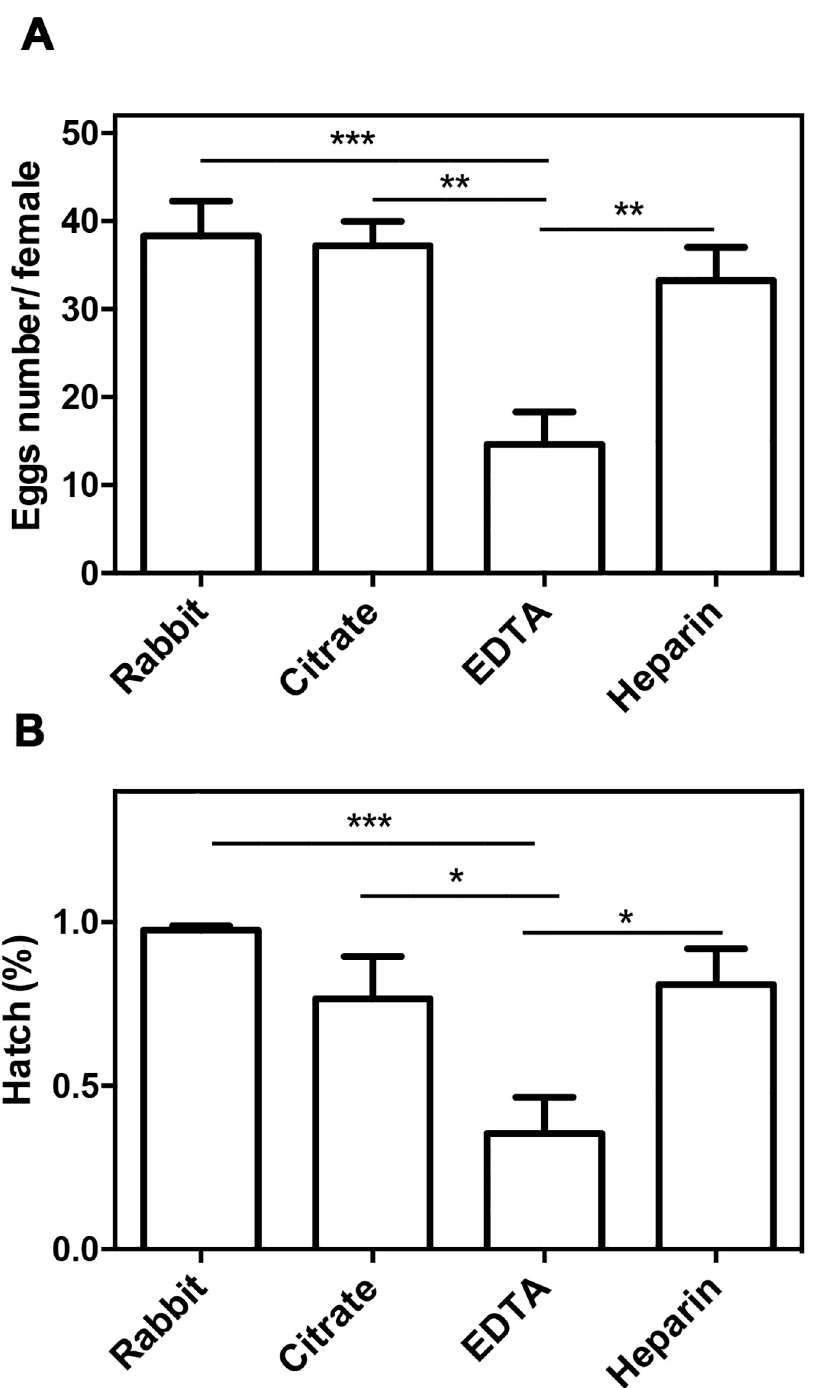
Fig 2. Effects of anticoagulants on fertility. Females were fed on live rabbit or artificially on blood collected with citrate, EDTA, or heparin as anticoagulants. After 40 days, the number of eggs (A) and nymphs was quantified, and the hatch percentage was calculated (B). Statistical analysis: one-way ANOVA, followed by Tukey test, total females number observed N Rabbit 12, N citrate 10, N EDTA 8, N Heparin 12 (A), and total number of eggs observed N Rabbit 470, N citrate 372, N EDTA 117, N Heparin 399. � P < 0.05; �� P < 0.01; ��� P < 0.001.